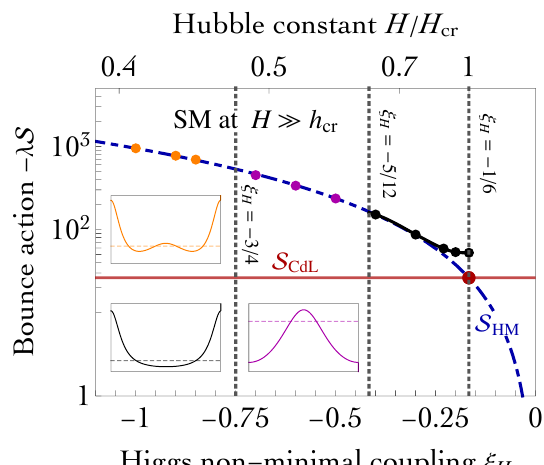
Figure 4 . Bounce actions for the potential V = (cid:21)h 4 = 4 with (cid:21) < 0 and a non-minimal (cid:24) H coupling to gravity. As the action is proportional to 1 =(cid:21) , we plot the product (cid:0) (cid:21) S as function of (cid:24) H . The red dot denotes the Coleman bounces of eq. (4.7). The other dots denote multi-bounces, as plotted in the